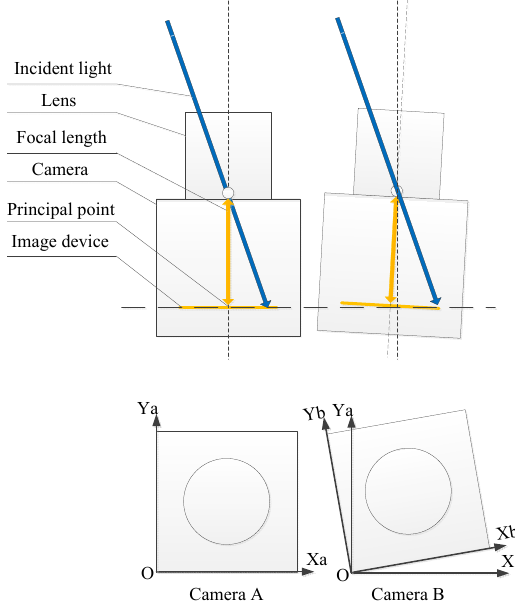
Figure 4. Inconsistency caused by extrinsic parameters.